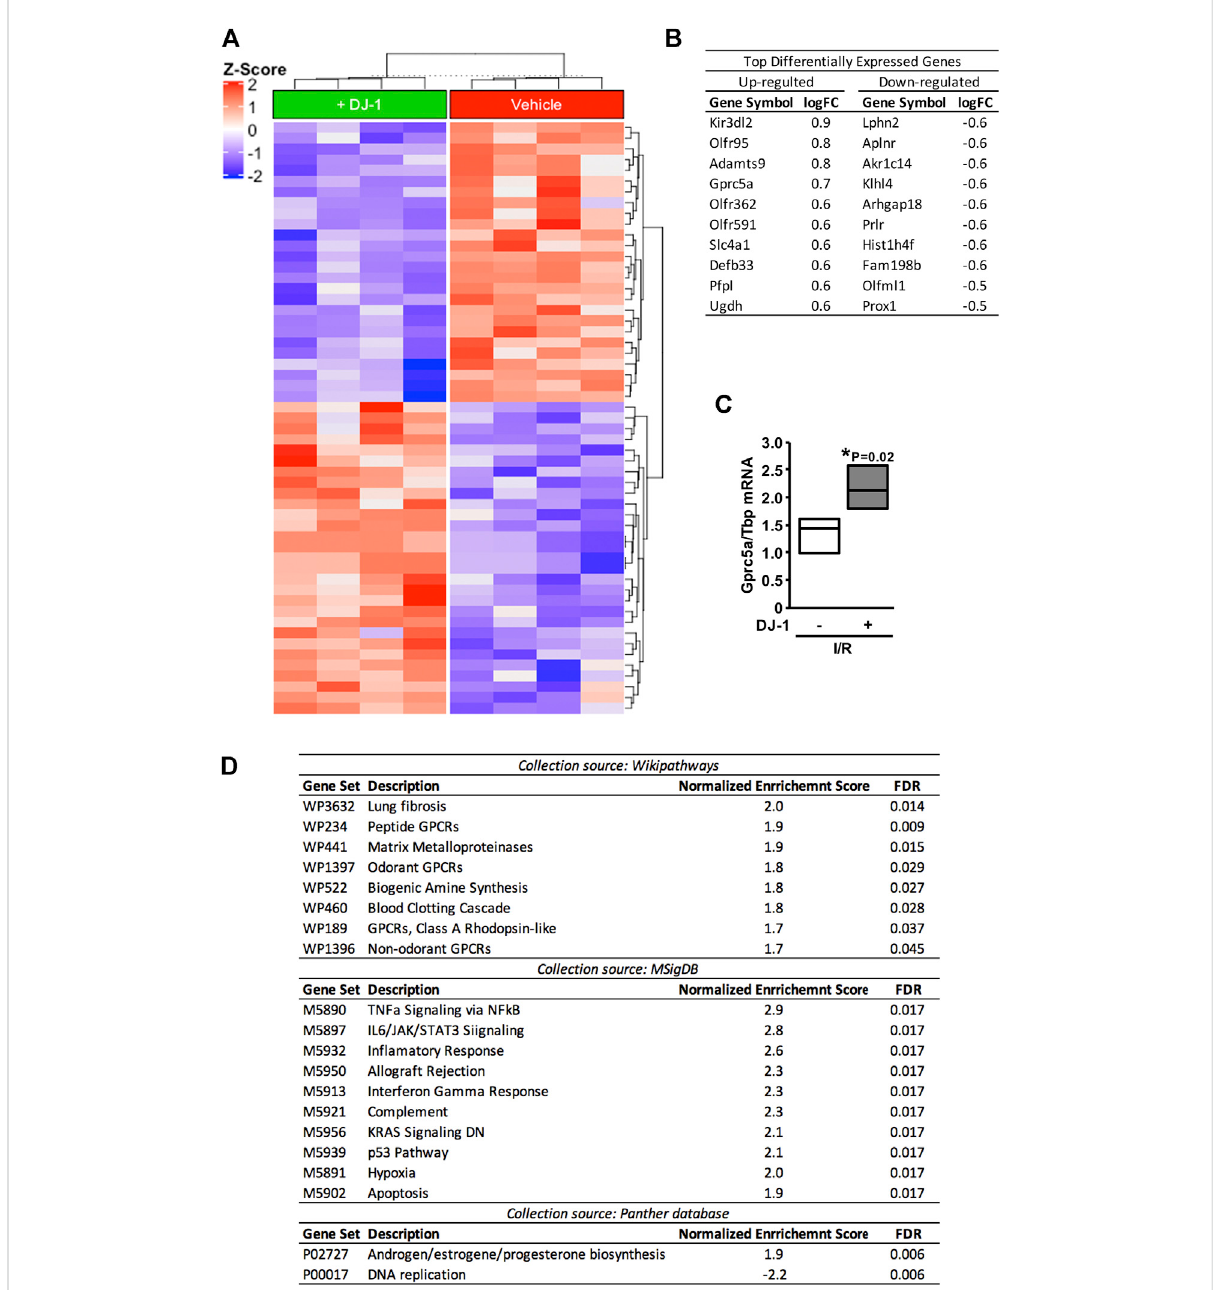
Differential geneexpressionpro fi leafterischemia/reperfusion,inthepresenceandtheabsence ofasystemicadministrationofDJ-1. (A) .Heat- maprepresentationofdifferentiallyexpressedgenes. (B)